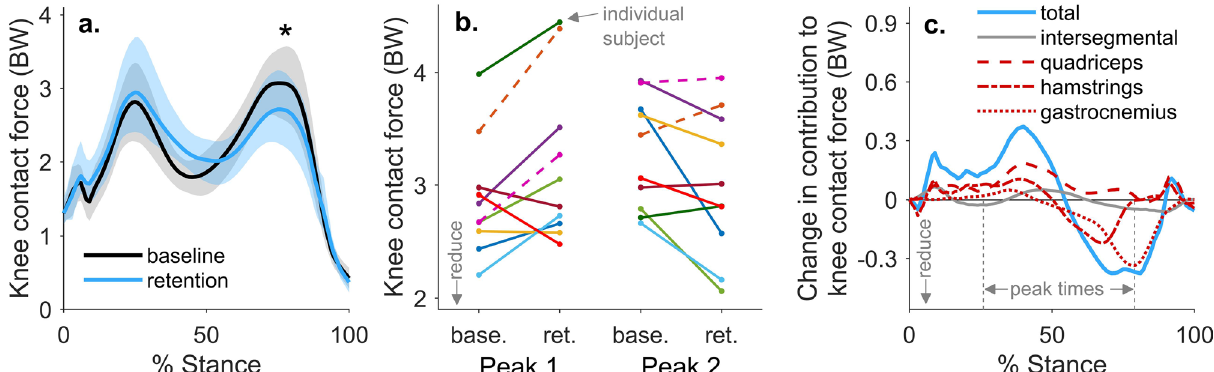
Figure 6. The effect of a gastrocnemius avoidance coordination pattern on knee contact force. ( a ) The mean (line) and standard deviation (shading) of knee contact force for the participants who reduced late-stance gastrocnemius activation during the retention trial (n = 8). These participants reduced their second peak of knee contact force compared to baseline (*p = 0.029, paired t test). ( b ) Changes in the first and second peak contact force between baseline (base.) and retention (ret.) are shown for all participants (n = 10), with the two participants who did not retain a reduction in late stance gastrocnemius activation represented with dashed lines. Six of the eight individuals who reduced late-stance gastrocnemius activation reduced their second peak knee contact force, but five increased their first peak. ( c ) For the eight subjects who reduced late-stance gastrocnemius activation, the change in knee contact force is decomposed into the intersegmental and muscle force components. Reductions in the second peak of knee contact force are primarily driven by reductions in gastrocnemius